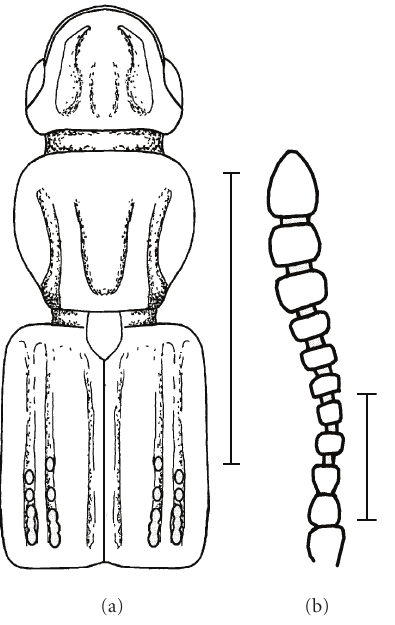
Figure 1: Fore body (a), antenna (b) of Thoracophorus simplex (scale bar (a) 0.5 mm, (b) 0.1